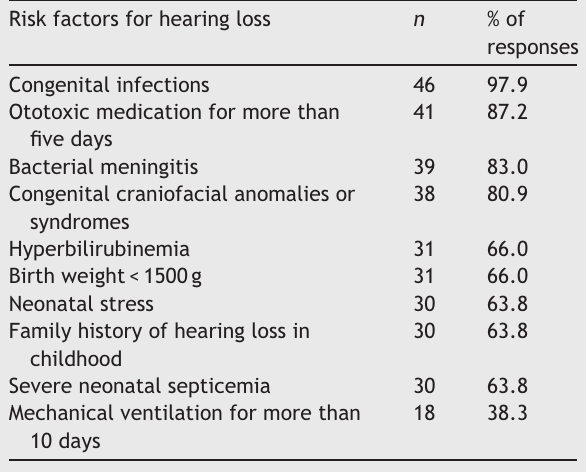
Risk factors for hearing loss reported by respon- dents ( n = 47).